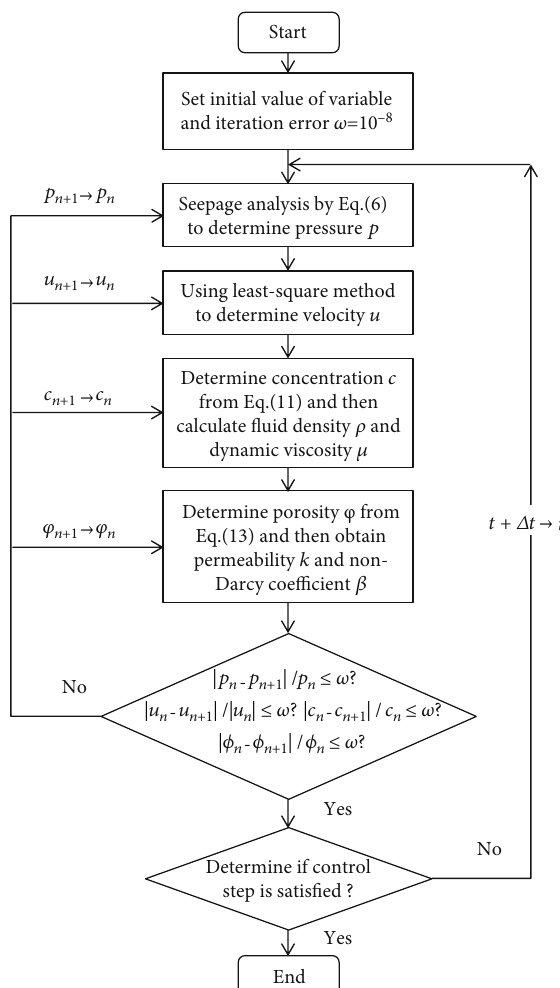
Figure 1: Flowchart of the numerical